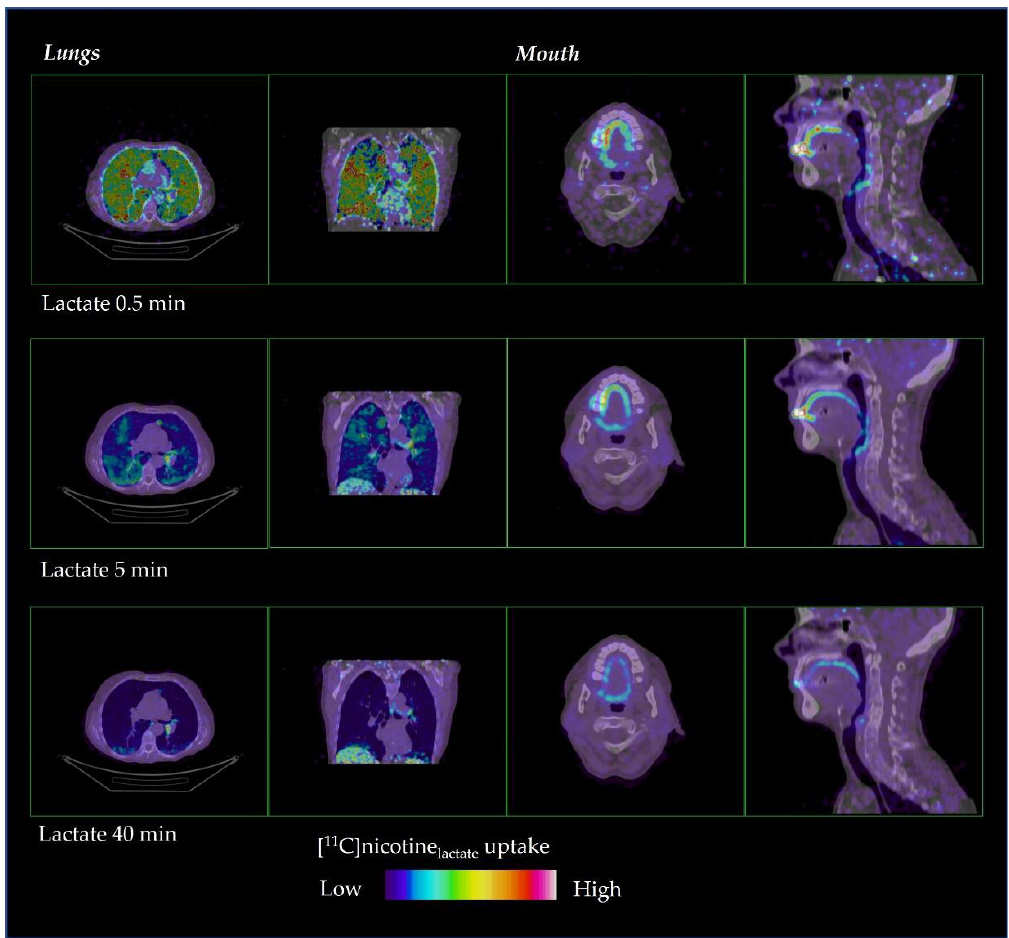
Figure 3. Representative distribution of [ 11 C]nicotine lactate in lungs and mouth at 0.5, 5 and 40 min after inhalation.